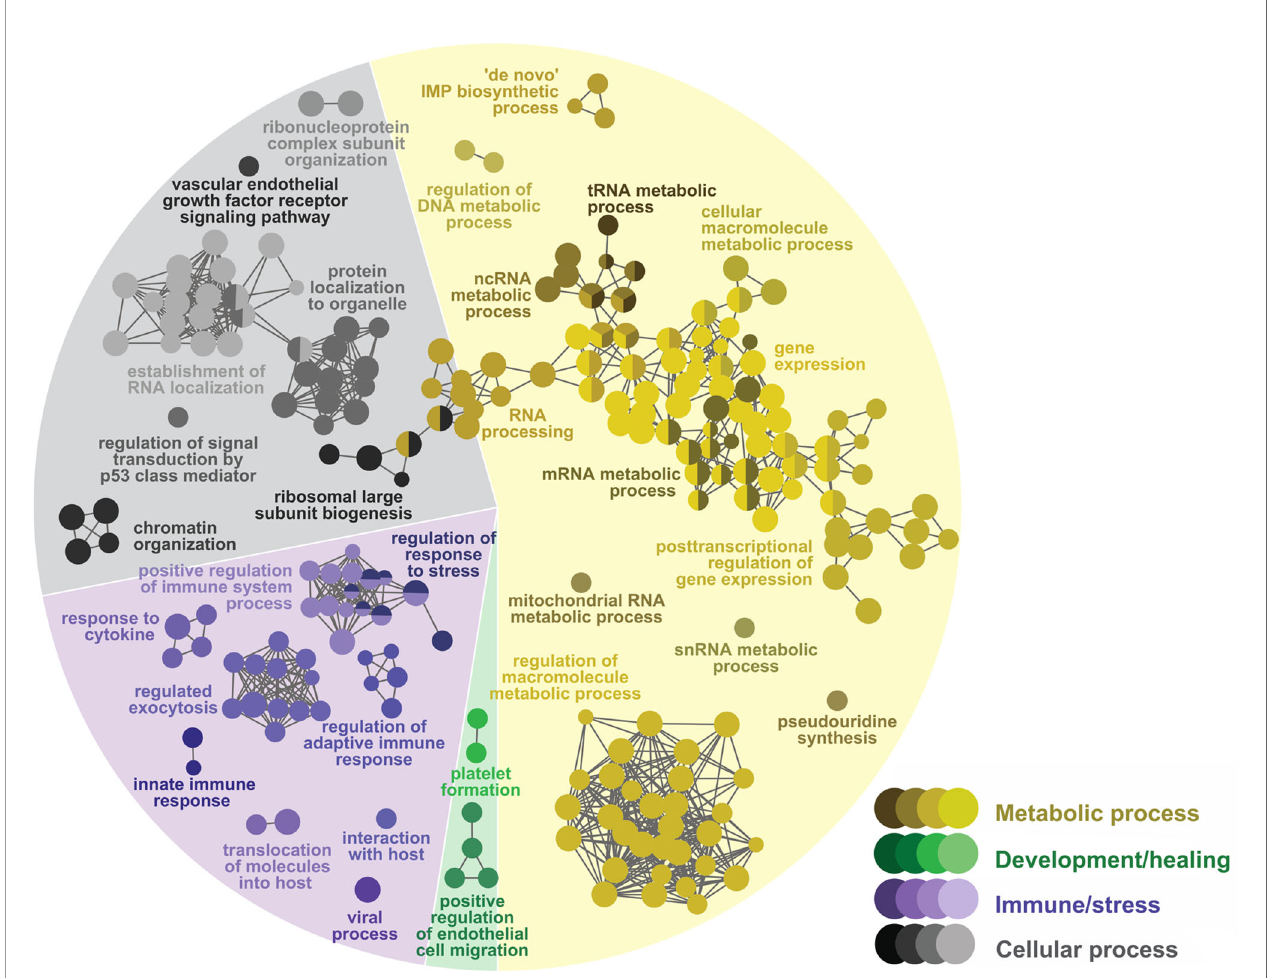
FIGURE 5 | Network GO term enrichment analysis of the differentially expressed genes (DEGs) in the COS list. Nodes represent over-represented GO terms (right- sided hypergeometric test; adjusted p-value < 0.05). Nodes are colored according to their assigned functional theme. Highly related terms (kappa coef fi cient > 0.4) are connected with grey lines. Single GO terms (i.e., single node) and GO networks are grouped and colored by functional theme (e.g., metabolic process, immune/ stress) and arranged to fi t the pie chart sectors representing the proportion of GO terms in each functional theme. Some GO groups comprised terms from different themes; in such cases, the group is colored according to the theme with the highest number of GO